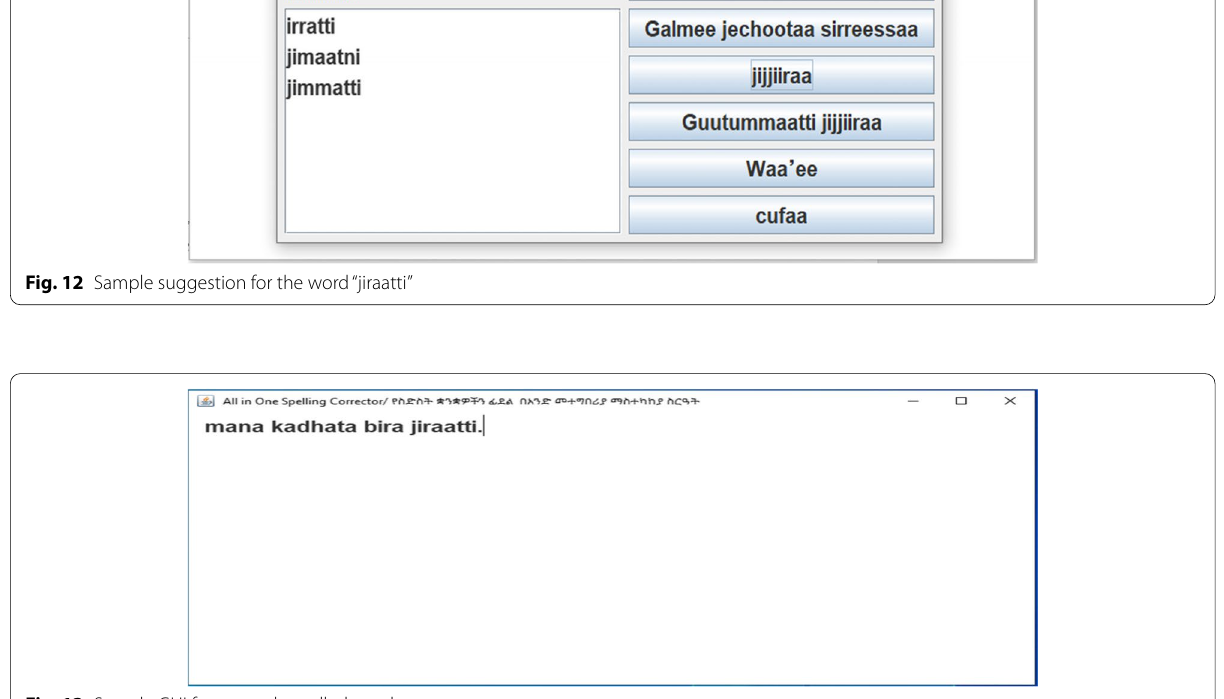
Fig. 13 Sample GUI for correctly spelled